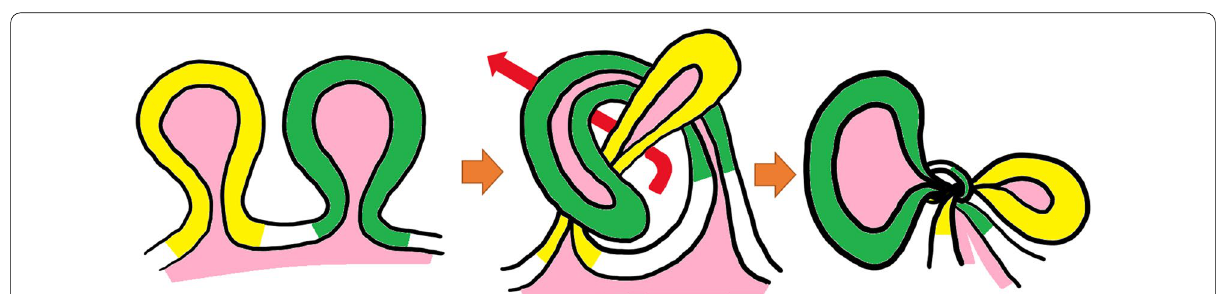
Fig. 4 Shema of true knot. One intestinal segment (green) passes through the portal formed by the crossing of another intestinal segment